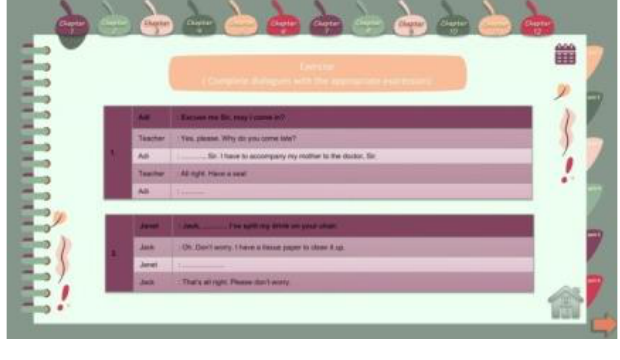
Figure 9. LEEF Exercises Page